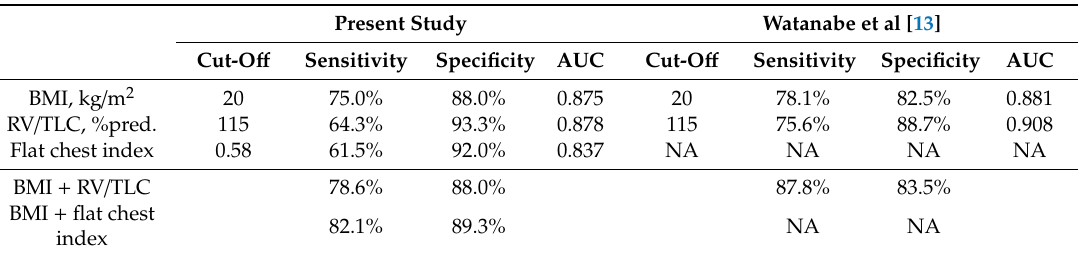
Table 2. Sensitivity, specificity, and area under curve of each parameter for discriminating IPPFE from